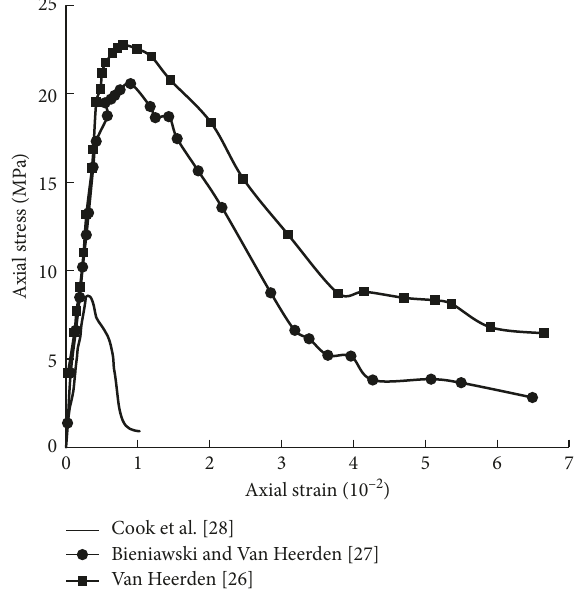
Figure 5: Complete stress-strain curve obtained for large-scale tests on